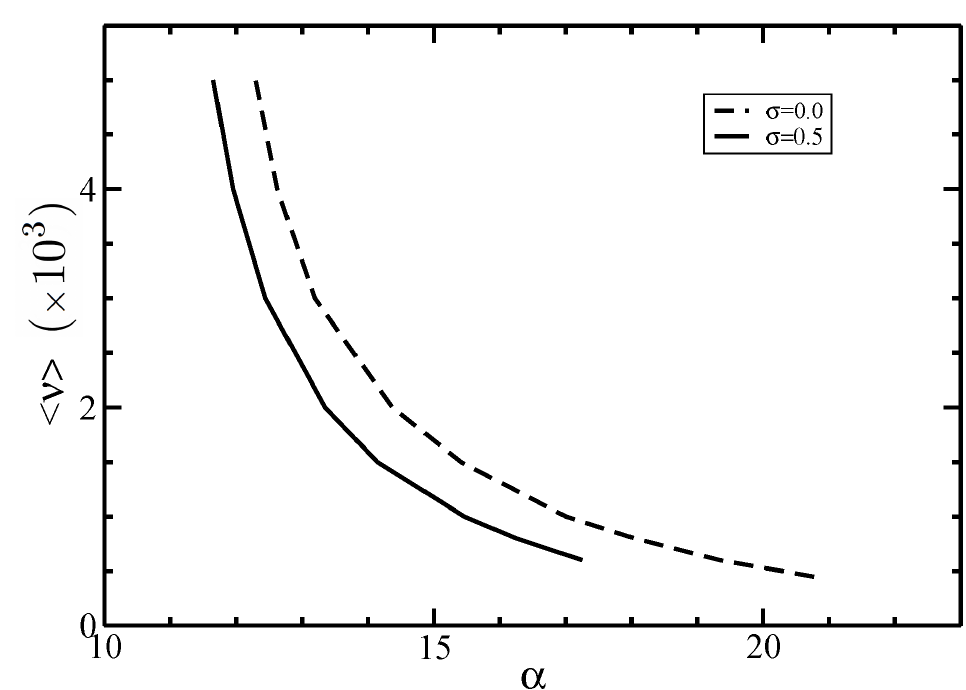
Figure 2. The parameter α as a function of the average size < ν > at the I–N phase coexistence. The normalized standard deviations are σ = 0 (dashed line) and 0.5 (solid line).